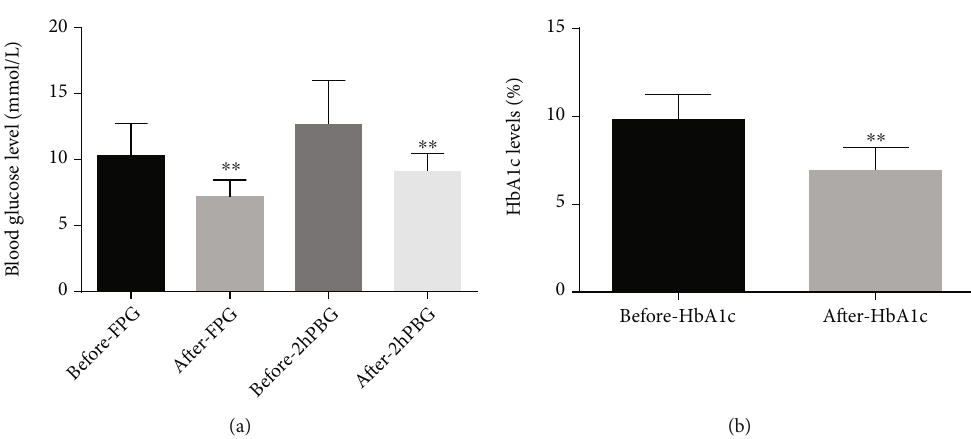
Figure 1: After liraglutide was added, FPG, 2hPBG, and HbA biochemical analyzer, and 2hPBG was measured by Accu-Chek advantage electronic sensing portable blood glucose meter ( ∗∗ p < 0 : 01 ).